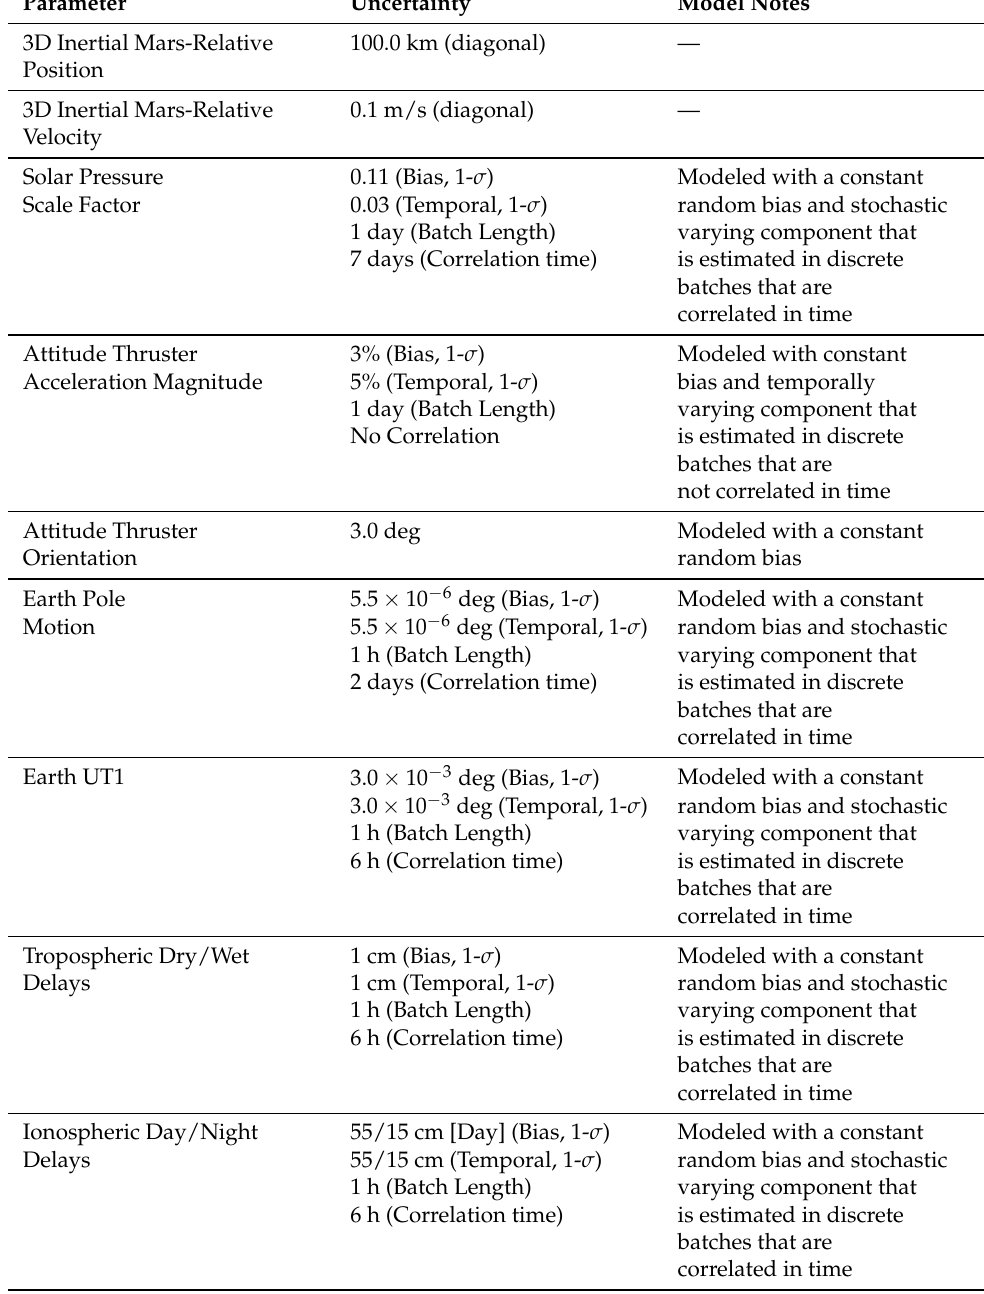
Table 1. Nominal Filter Setup Used in